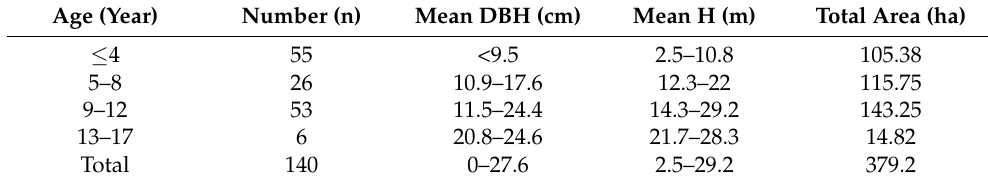
Table 1. Basic information of the 140 eucalyptus FSC.